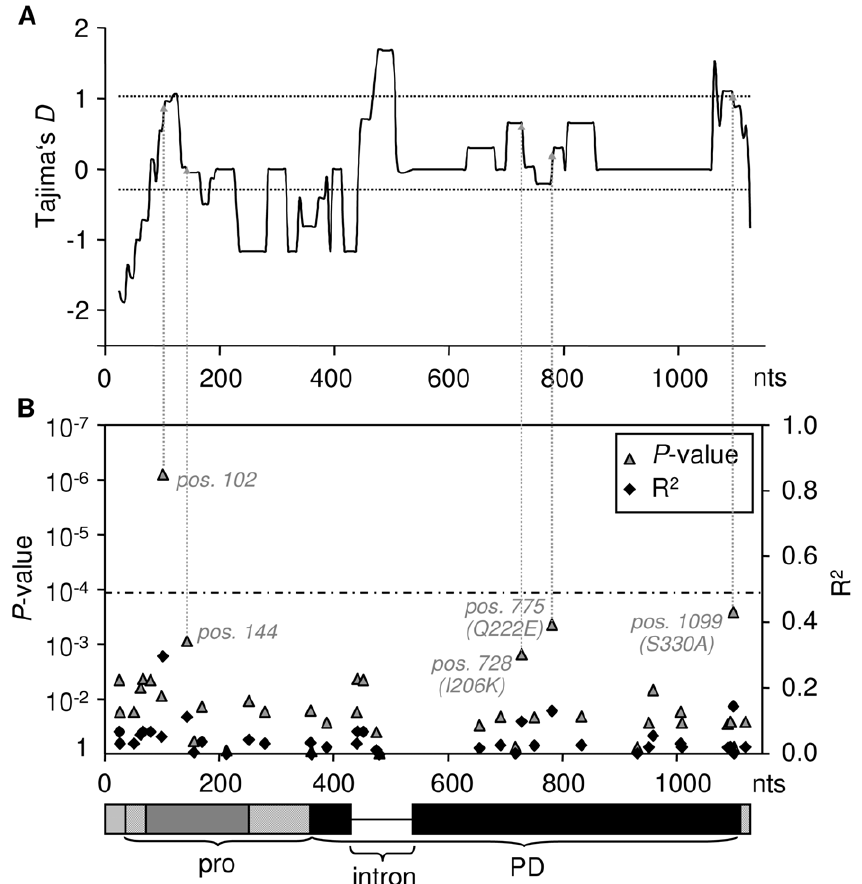
Figure 3. Association of the weak HR phenotype with sequence polymorphism. (A) Tajima’s D across the two RCR3 loci. The dotted lines indicate the mean and maximum of D T measured at 14 reference loci. D T is elevated at sites that are associated with the weak HR compared to the neutral expectation (=0) and even more so compared to the genomic average. (B) Association of SNPs and phenotypic variation in HR response with P -value of the correlation (left y-axis) and correlation coefficient (right y-axis). Values were corrected using the Bonferroni-method (dashed line indicates the 5% significance threshold). The dashed arrows indicate the corresponding Tajima’s D values for all polymorphisms associated with the attenuated HR phenotype. The structure of the gene is indicated below the x-axis (grey and black boxes are the exons, pro=pro-domain, PD=protease domain).